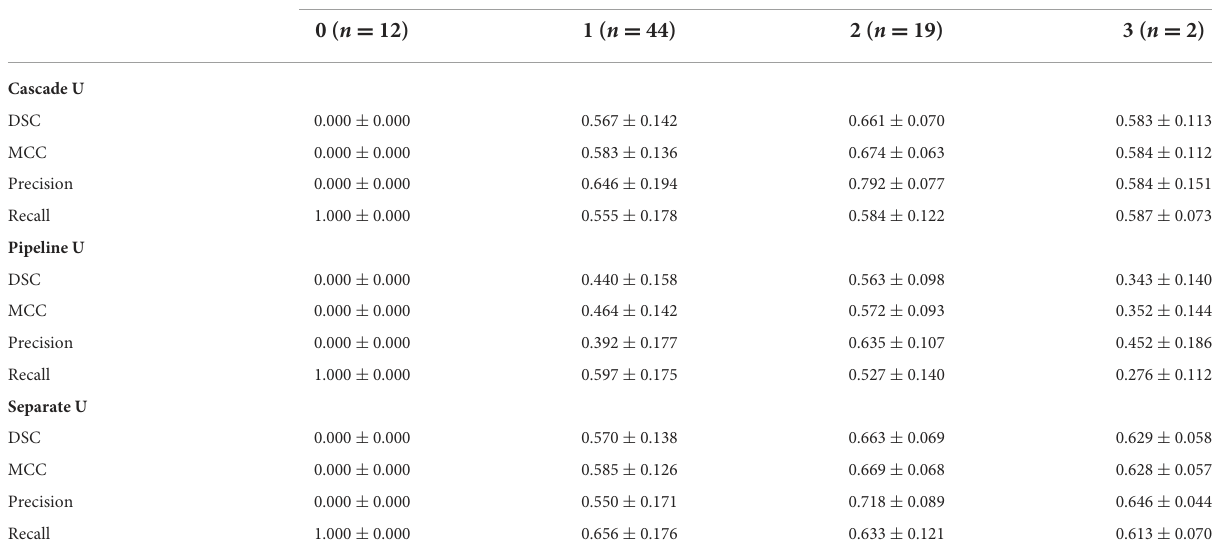
TABLE 4 Performance of three models on subjects’ dWMHs with different Fazekas scores. Fazekas